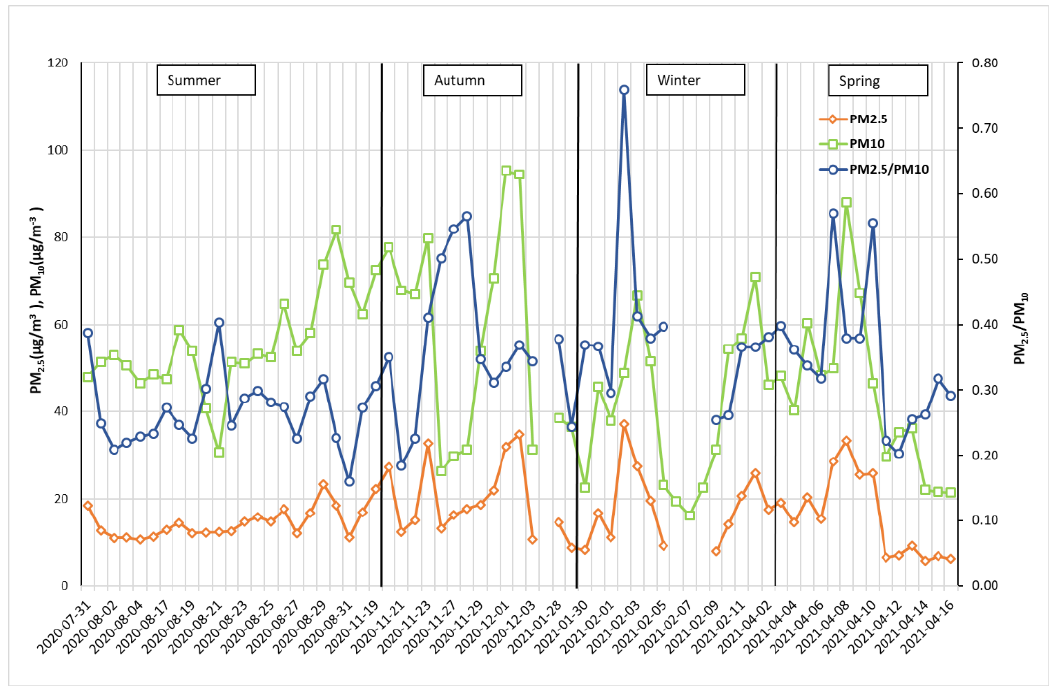
Figure 3. Temporal variations of ambient PM 10 and PM 2.5 concentrations (µg/m 3 ), and PM 2.5 /PM 10 ratios, subdivided into seasons in Kenitra during the study period (2020–2021). Table 1. Descriptive statistics of daily concentrations of PM 10 , PM 2.5 , and BC obtained